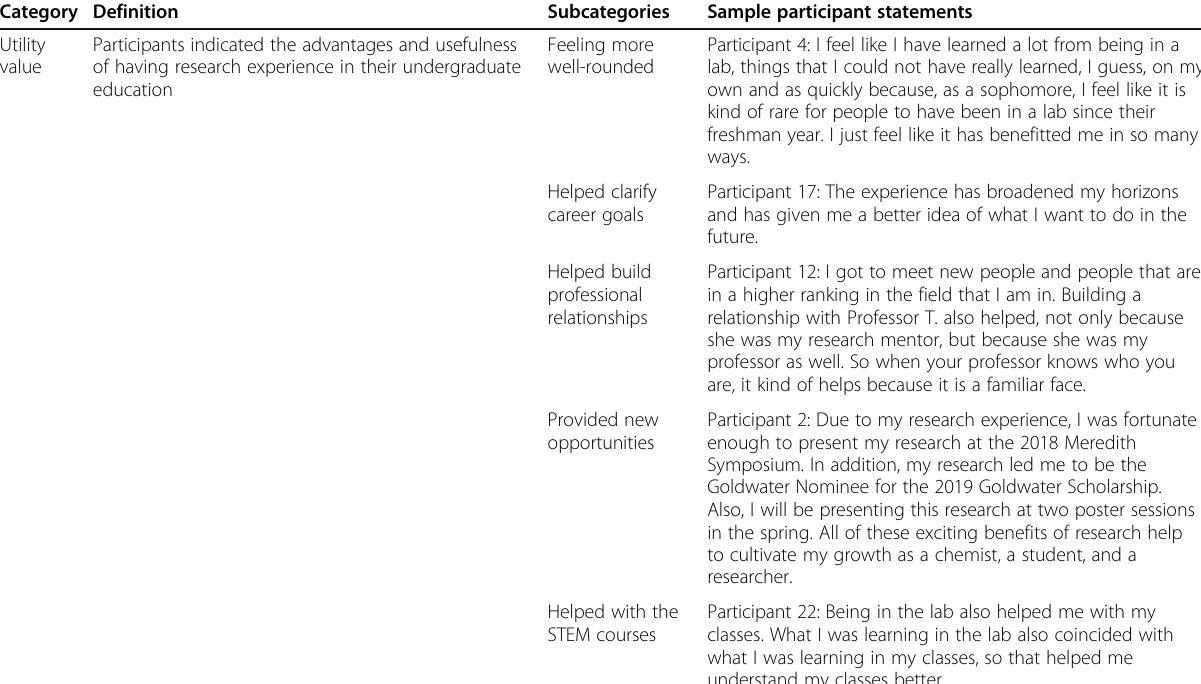
Table 3 Utility value definition, subcategories, and examples of participants ’ statements Category